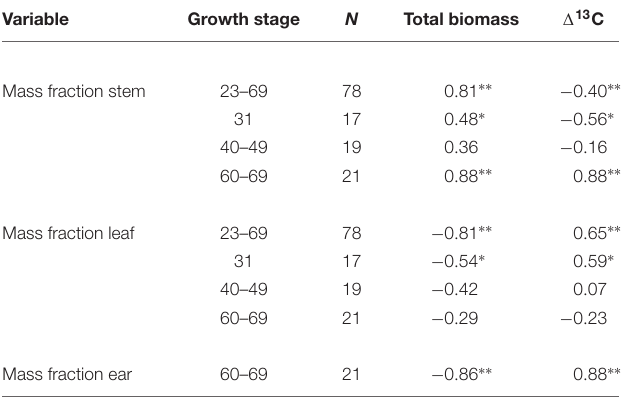
TABLE 3 | Correlation coefficient (r) for leaf, stem and ear mass fraction with total biomass and (cid:49) 13 C among the six environments. Variable Growth stage N Total